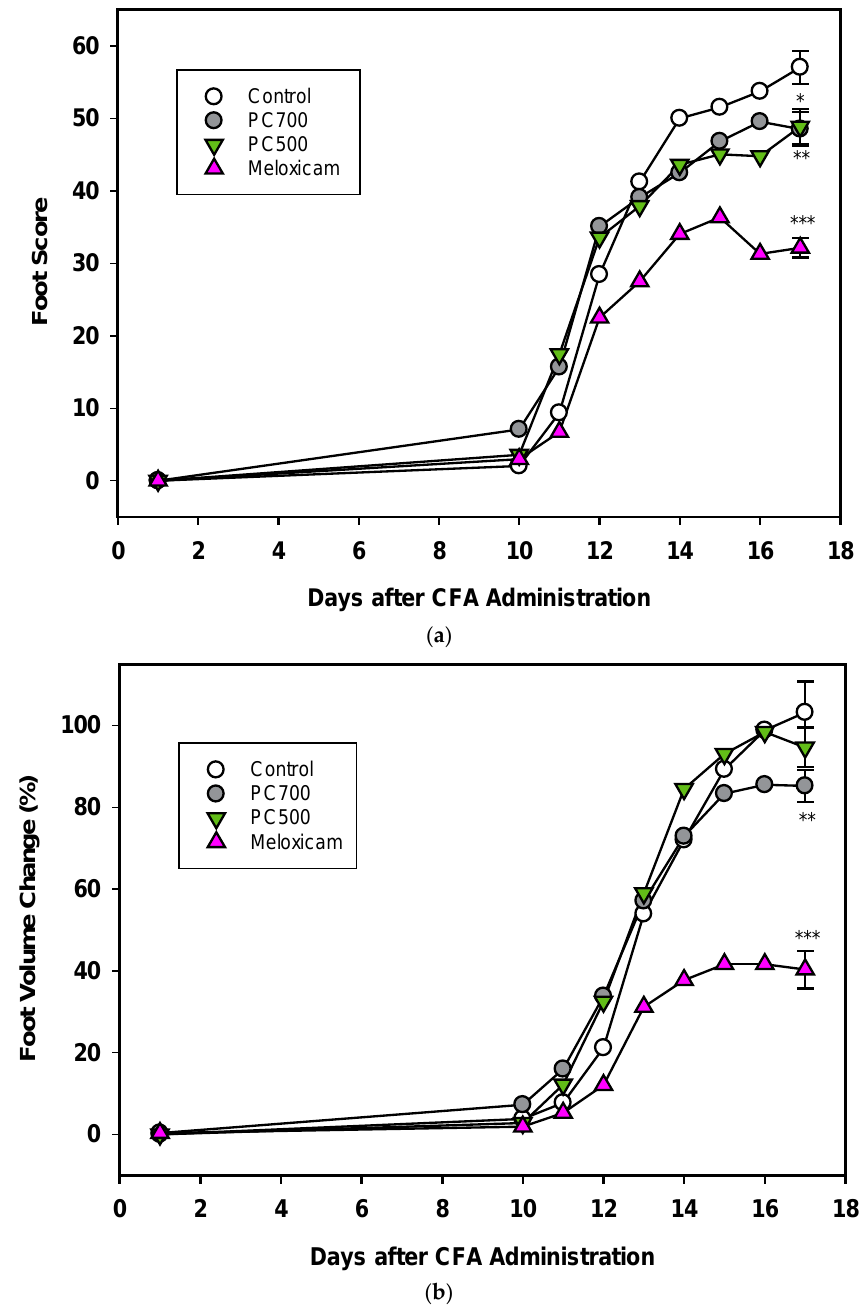
Figure 7. ( a ) The e ff ects of PC700 and PC500 (as described in Methods section and Table 1) in the diet of rats on joint inflammation after the administration of complete Freund’s’ adjuvant (CFA) were compared with a control and the anti-arthritic drug meloxicam, based on the American Rheumatism Association (ARA) Scoring System (foot score). Values are means, n = 8 for all groups except control ( n = 5). Error bars are SEM and probabilities * p < 0.05, ** p < 0.01, *** p < 0.001. ( b ) The e ff ects of PC700 and PC500 in the diet of rats on joint inflammation after the administration of complete Freund’s adjuvant (CFA) were compared with a control and the anti-arthritic drug meloxicam, based on the change on foot volume (relative to the control at Day 17). Values are means, n = 8 for all groups except control ( n = 5). Error bars are SEM and probabilities * p < 0.05, ** p < 0.01, *** p < 0.001.